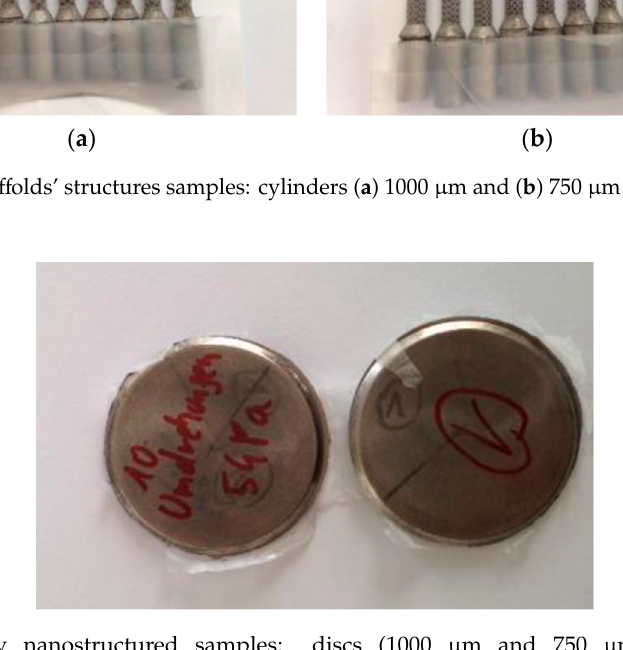
Figure 2. Alloy nanostructured samples: discs (1000 µ m and 750 µ m) received from UniVieVienna, Austria.